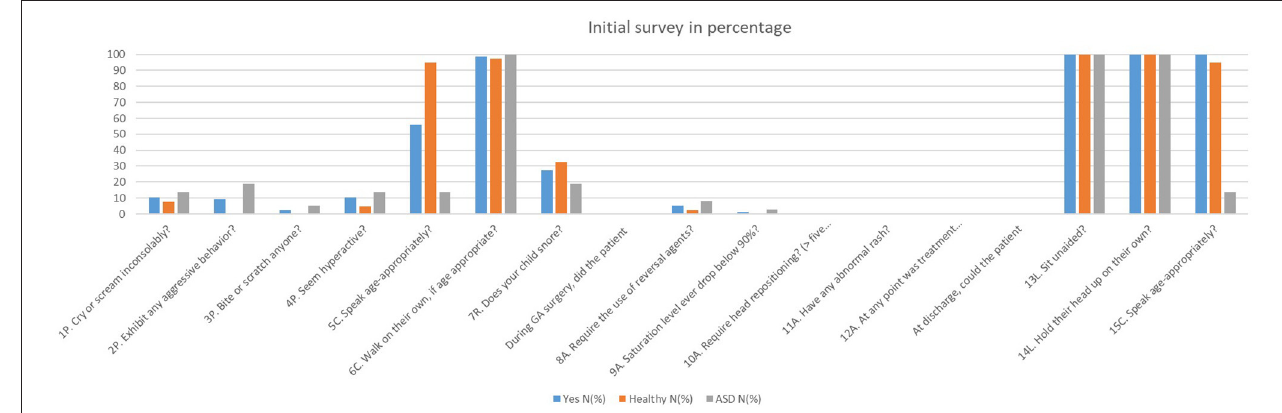
FIGURE 1 | Initial survey in percentage.